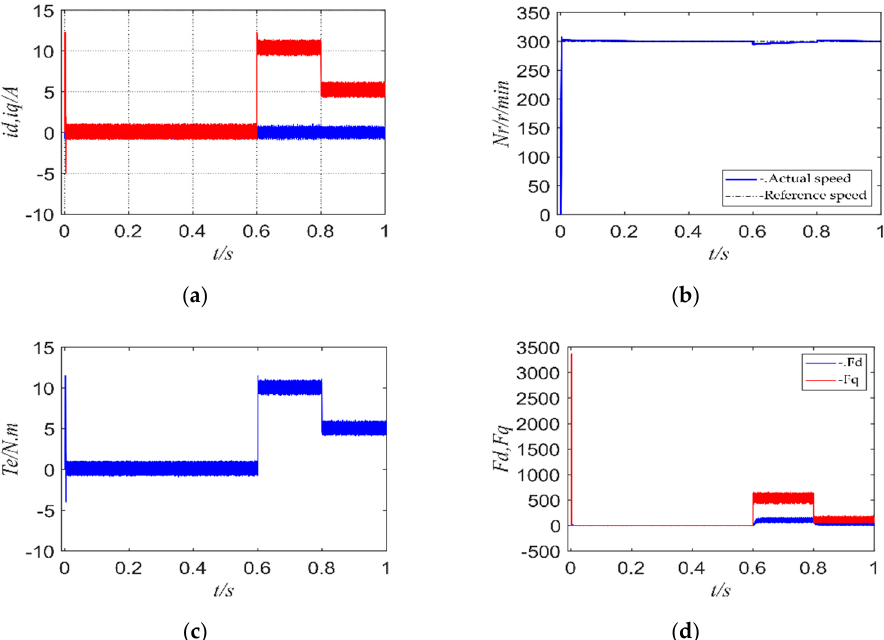
Figure 16. FCS-MFPCC simulation results under parameter perturbation when the sampling period is 10 us: ( a ) dq -axis current of FCS-MFPCC; ( b ) speed of FCS-MFPCC; ( c ) torque of FCS-MFPCC; ( d ) observed values of the unknown quantities Fd and Fq under parameter perturbation.